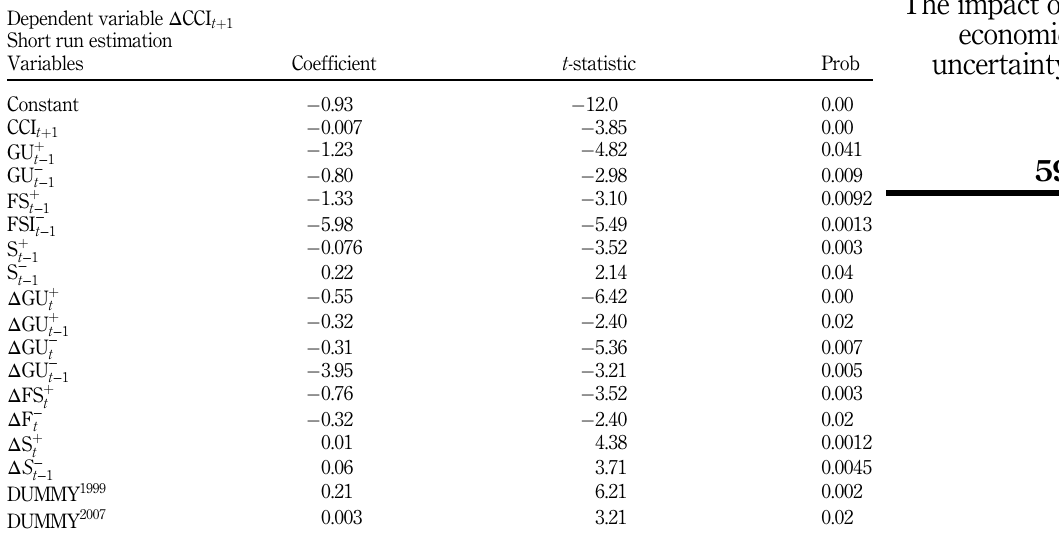
Table 6. Nonlinear